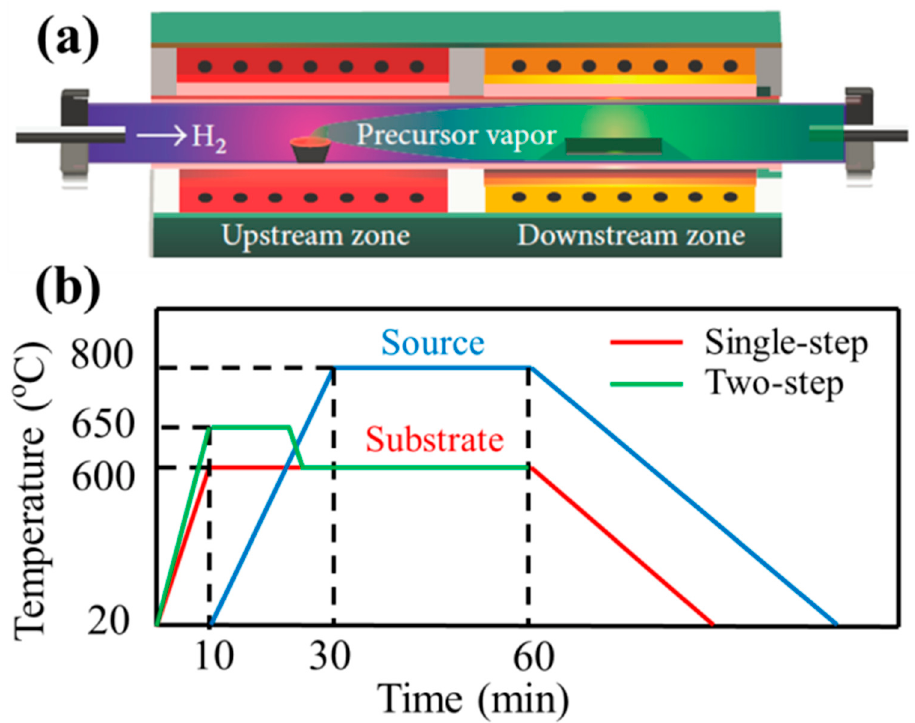
Figure 2. ( a ) Schematic illustration of the catalytic chemical vapor deposition (CVD) growth of GaAs nanowires (NWs) and ( b ) the temperature profiles. The typical dual-zone horizontal tube furnace, one zone is used for the solid source (upstream) and the other for the sample (downstream). Adapted with permission from [98].